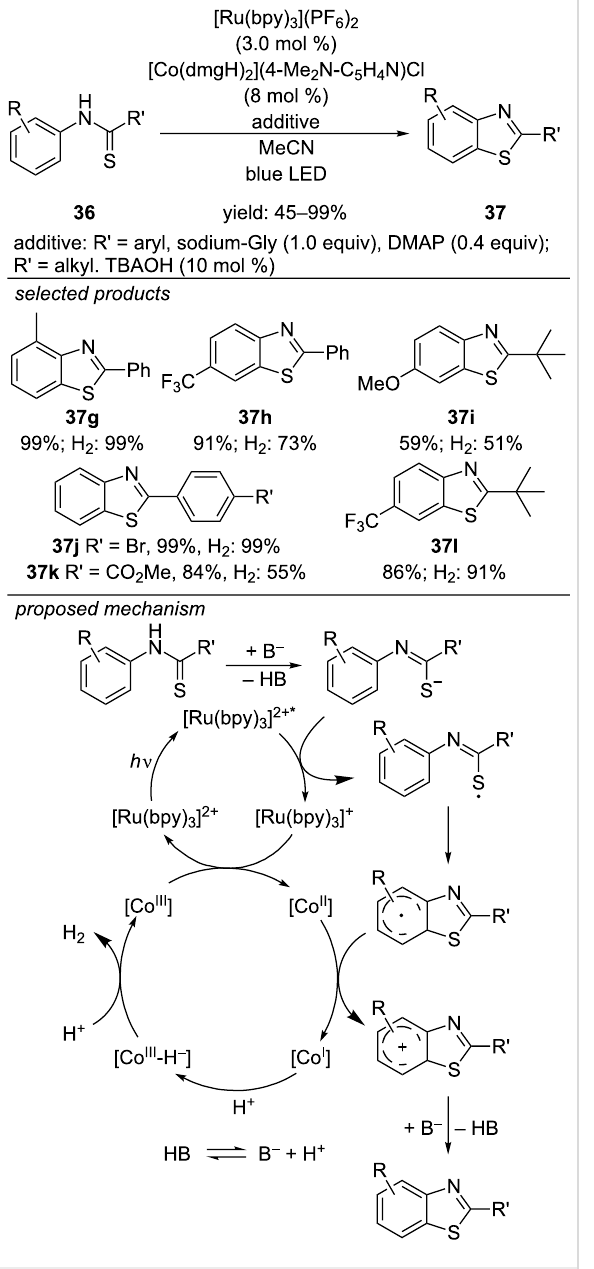
Scheme 32: Lei’s external oxidant-free synthesis of 2-substituted benzothiazoles by merging photoredox and transition metal catalysis.